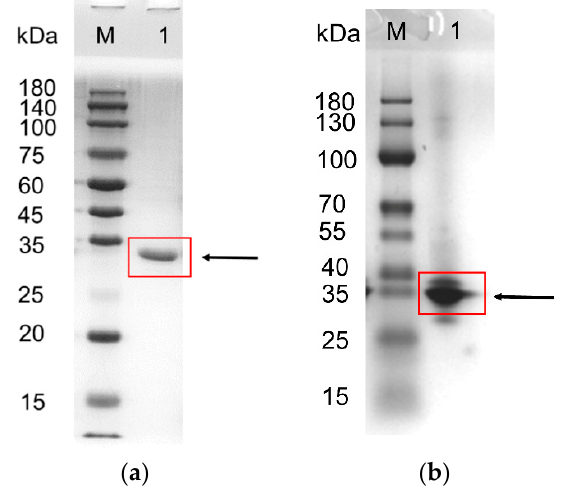
Figure 2. Analysis of molecular mass. ( a ) Sodium dodecyl sulfate polyacrylamide gel electrophoresis. ( b ) Native polyacrylamide gel electrophoresis. Lane M, the molecular mass of marker; lane 1, purified BpFAE.